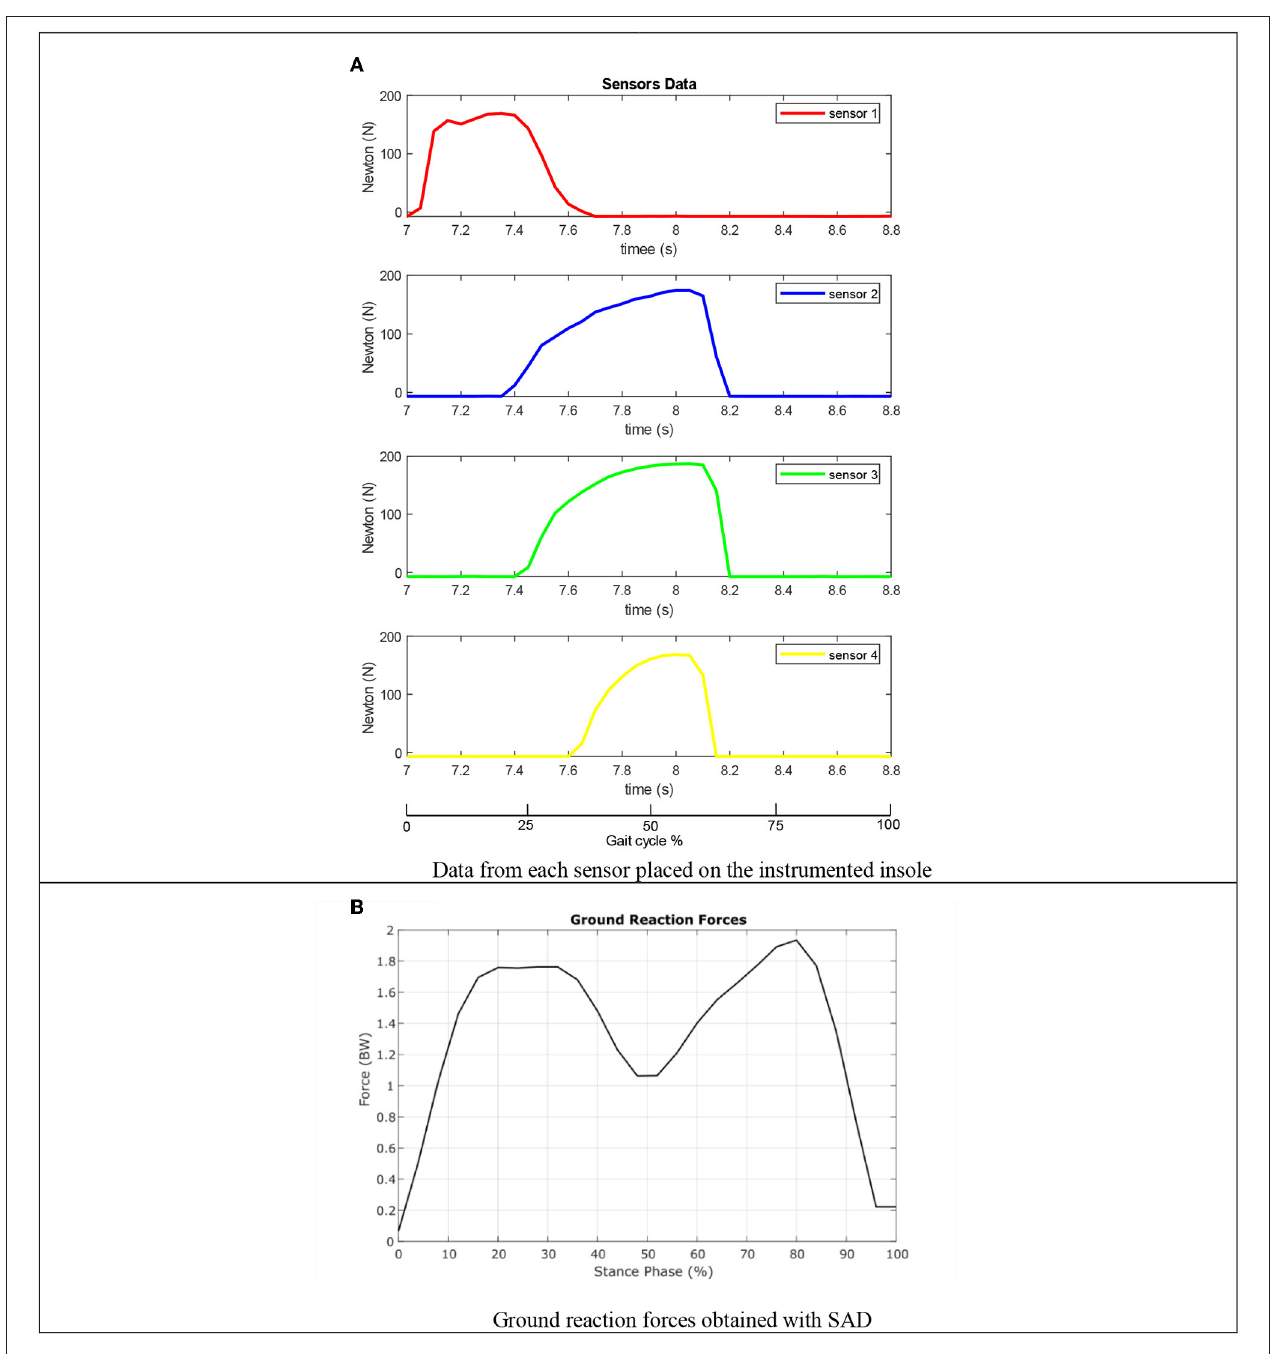
given in (1), Where GRF v are average of the vertical ground reaction forces, p is the number of samples measured by the DAS, and F i are the force value of each FSR sensor. Using (2) the graph in Figure 6B was obtained, where the variation of the forces depending on the percentage of the stance phase of the gait cycle. By comparing the shape and data obtained from the graph with the data reported